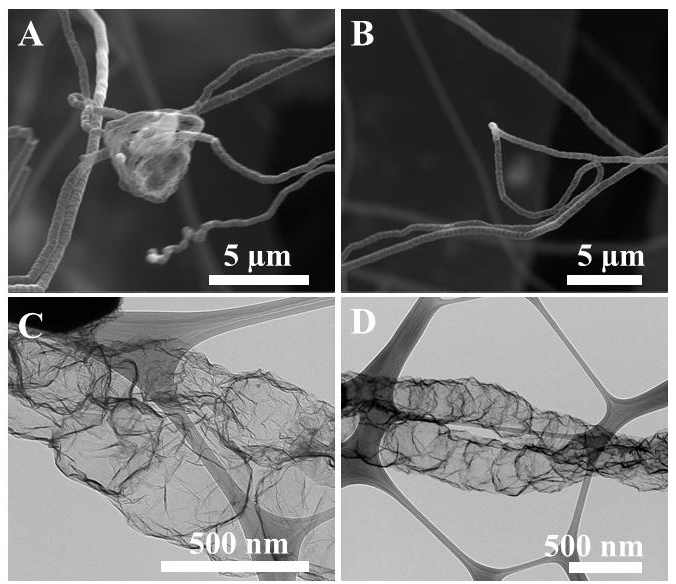
Figure 2. SEM images of N-CF obtained from ( A ) N-APG-Fe and ( B ) N-APG-Co. TEM image of ( C ) N-APG-Fe and ( D ) N-APG-Co.